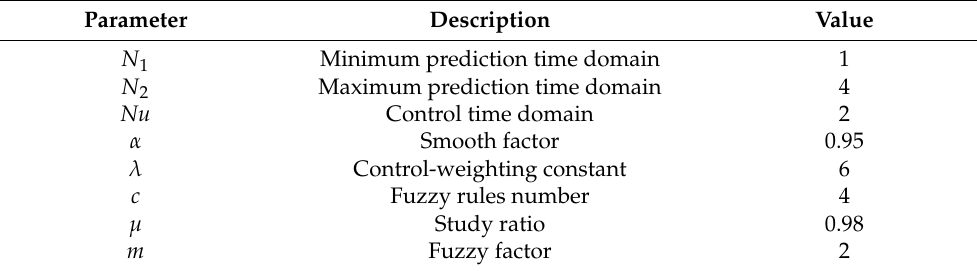
Table 2. System controller